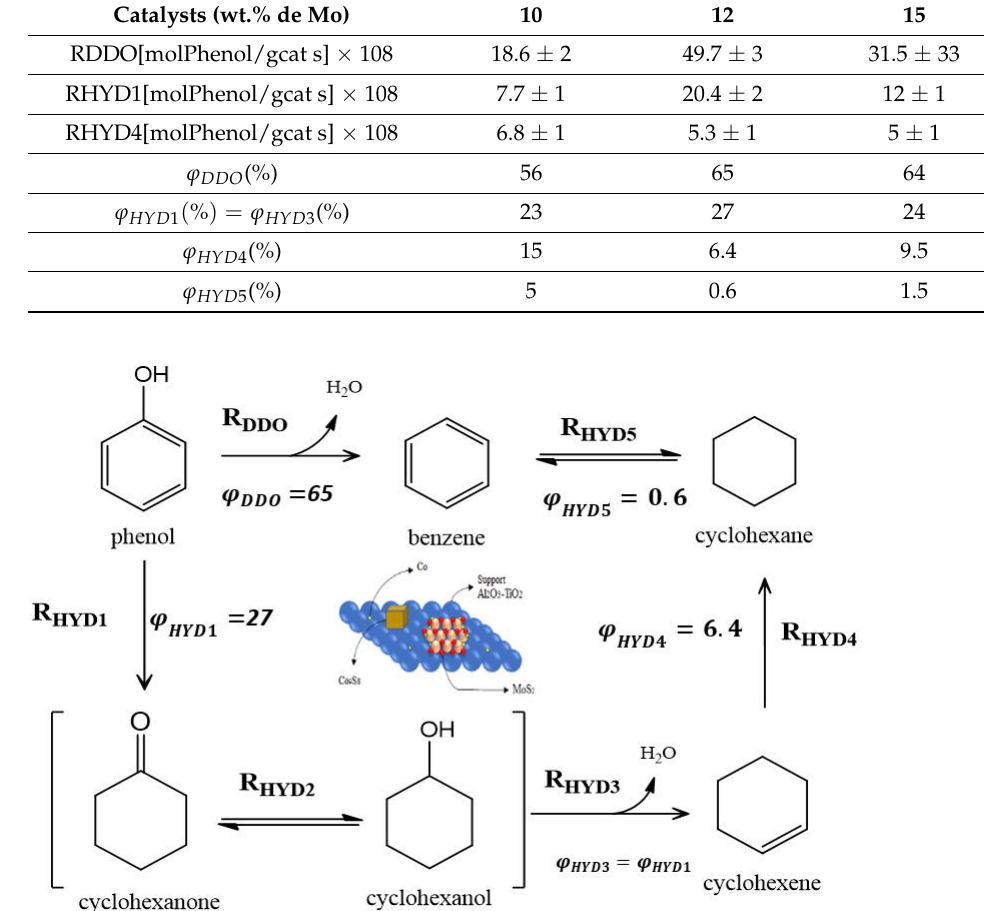
Figure 10. Reaction scheme and contribution analysis obtained for the CoMoS/AT2 catalyst with a Mo loading of 12 wt.% when this mixed oxide is evaluated during the HDO of phenol at 320 °C and 5.5 MPa. Contribution factor is obtained for a Mo loading of 12 wt.%.